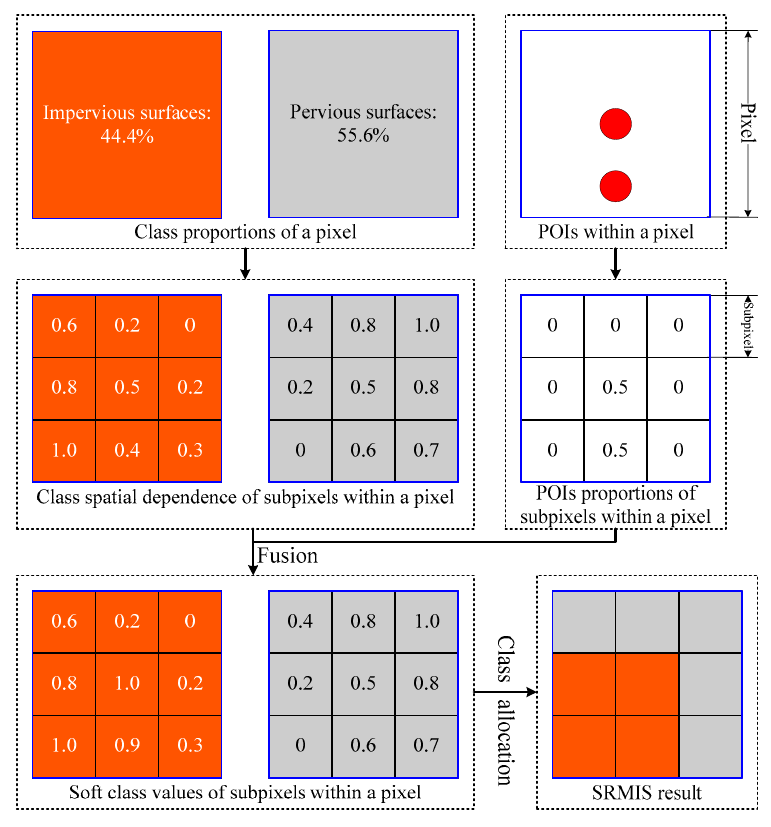
Figure 1. An example of the implementation of super-resolution mapping of impervious surfaces (SRMIS).